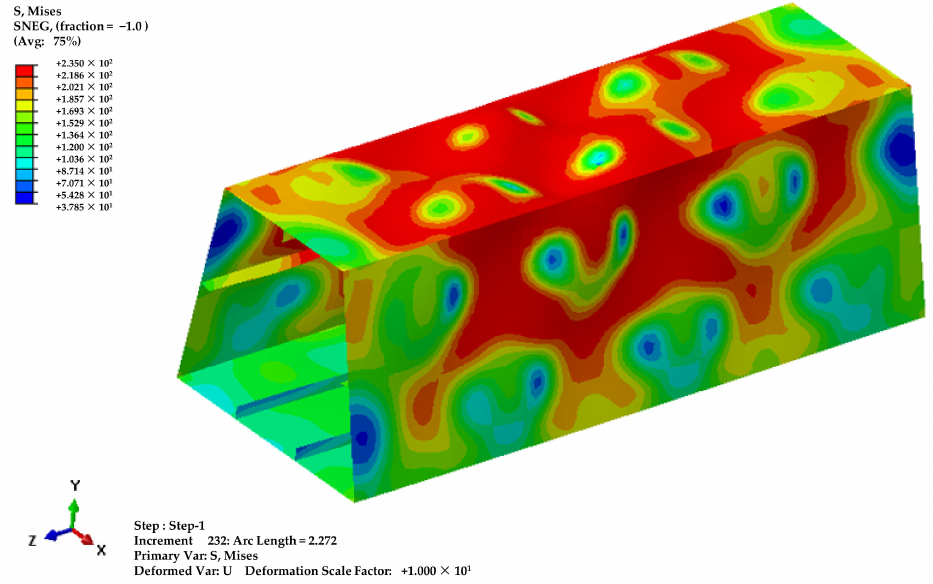
Figure 3. Finite element analysis of ultimate strength of box girder